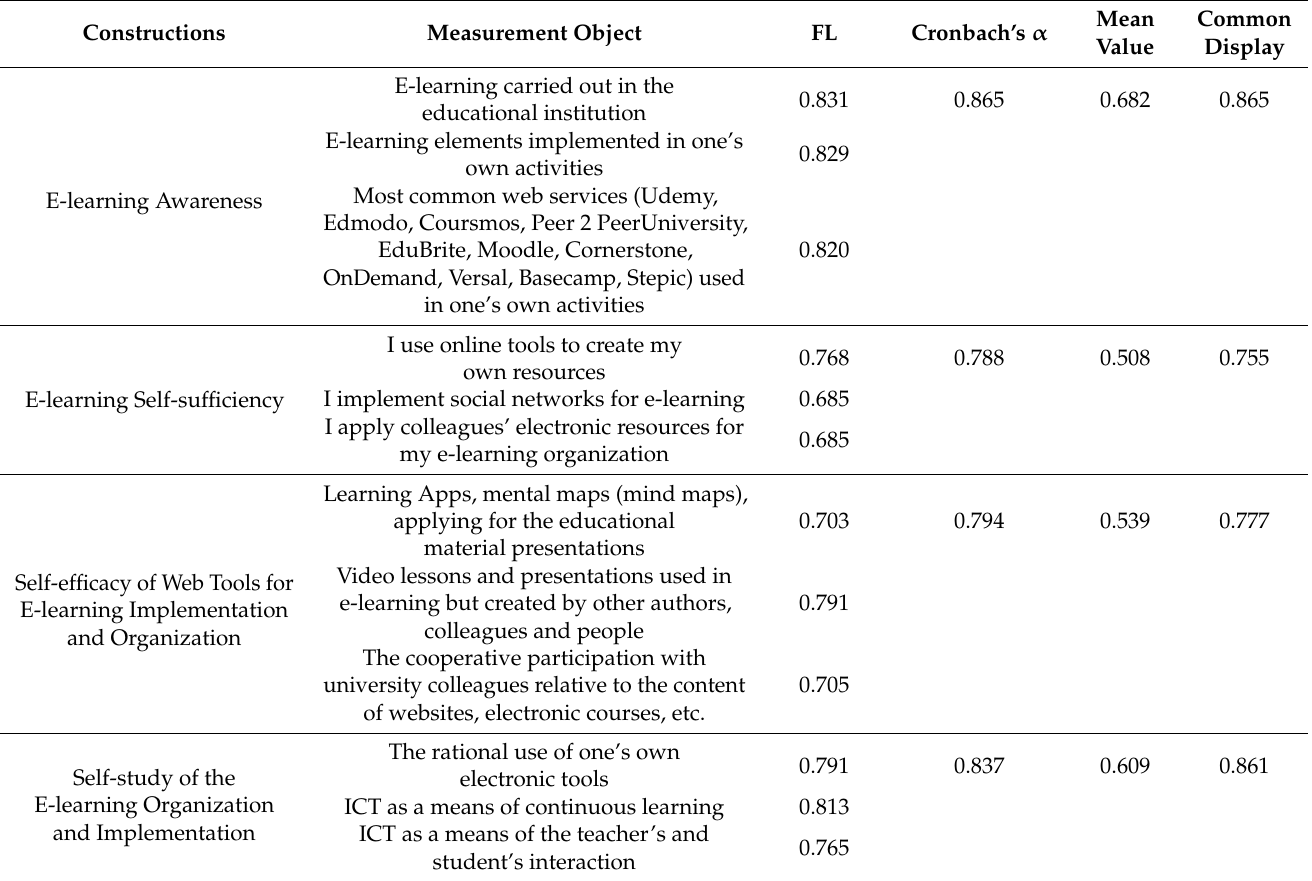
Table 2. Construction reliability and validity